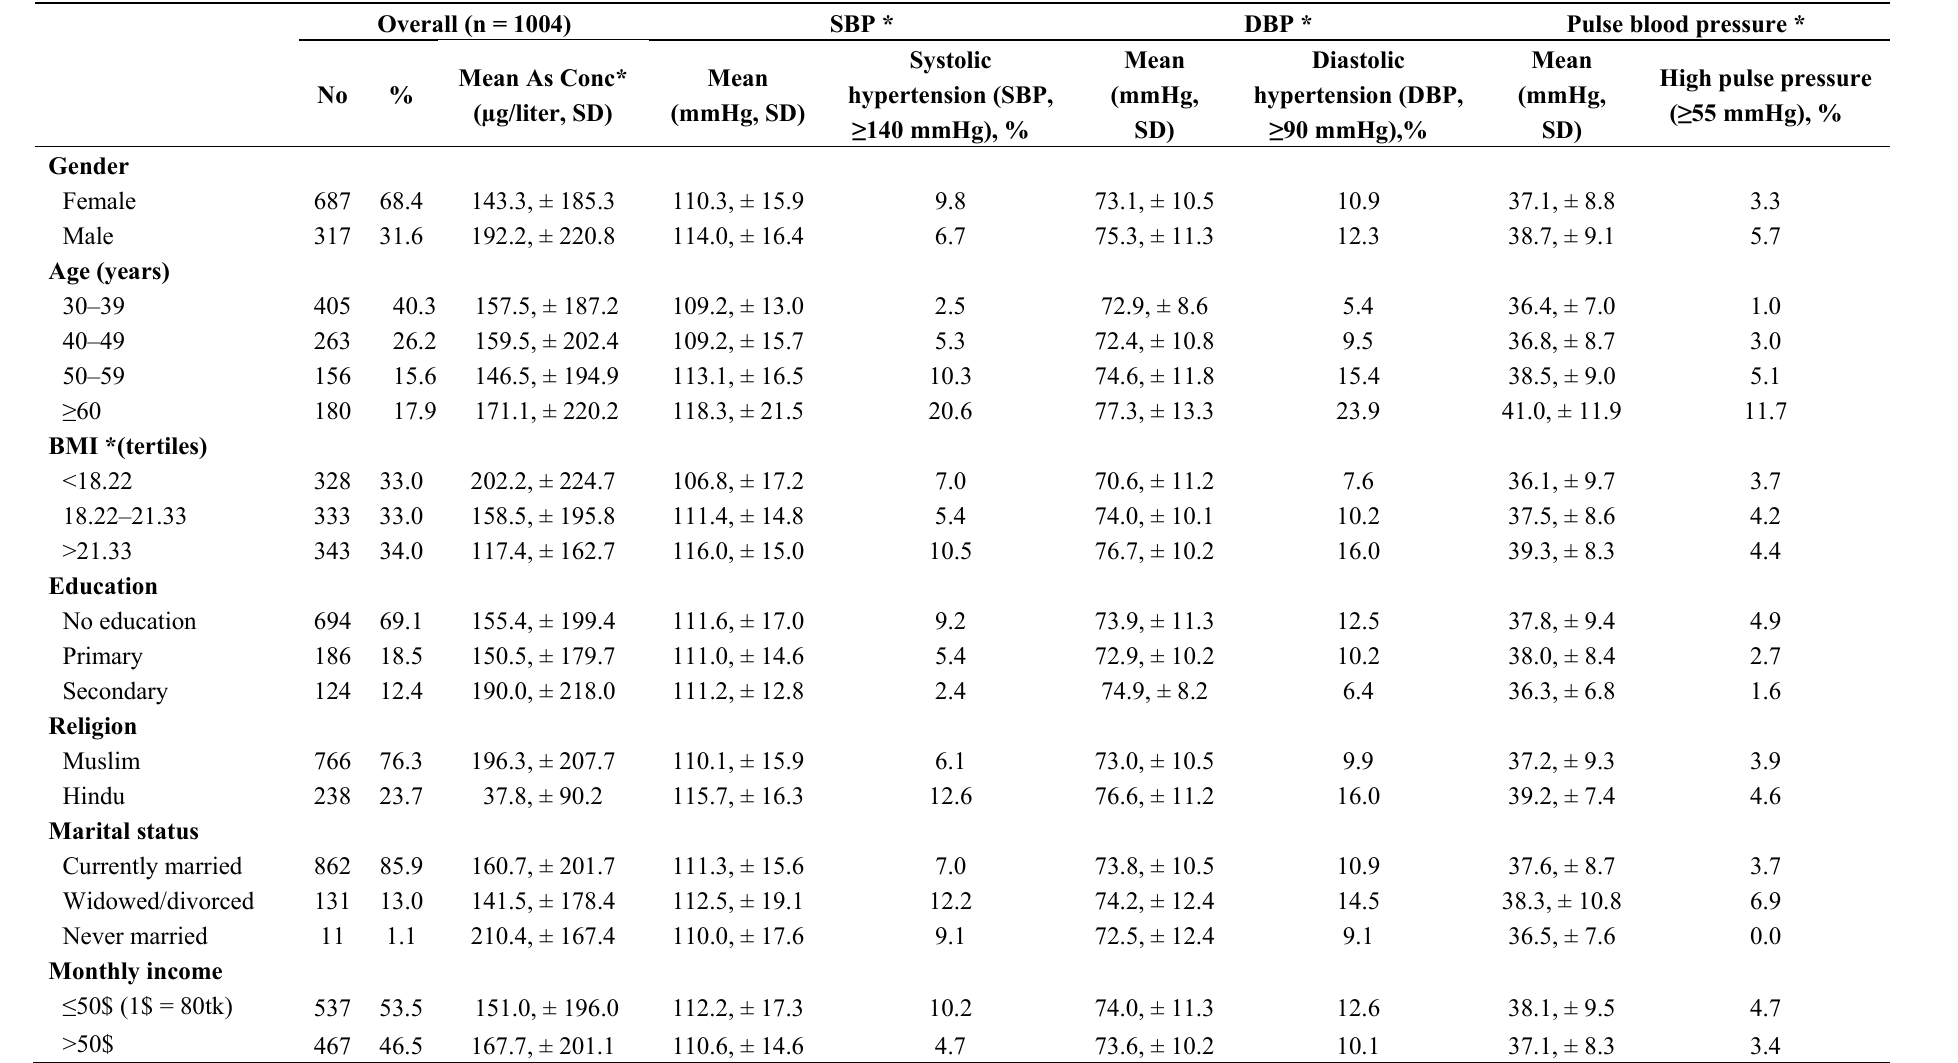
Table 1. Mean values of systolic blood pressure, diastolic blood pressure and pulse